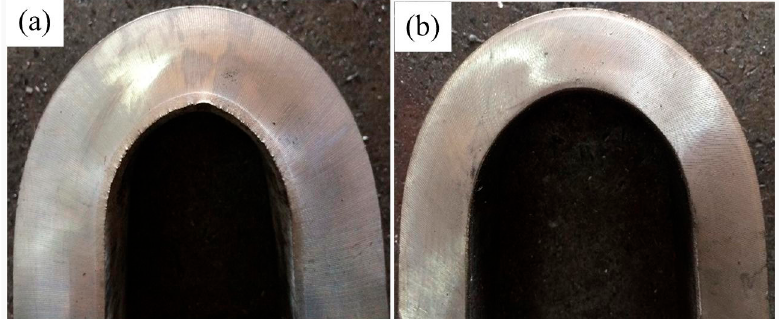
Figure 13. Bending test of the titanium clad steel plate with Nb interlayer: ( a ) Inner bending; ( b ) Outer bending.